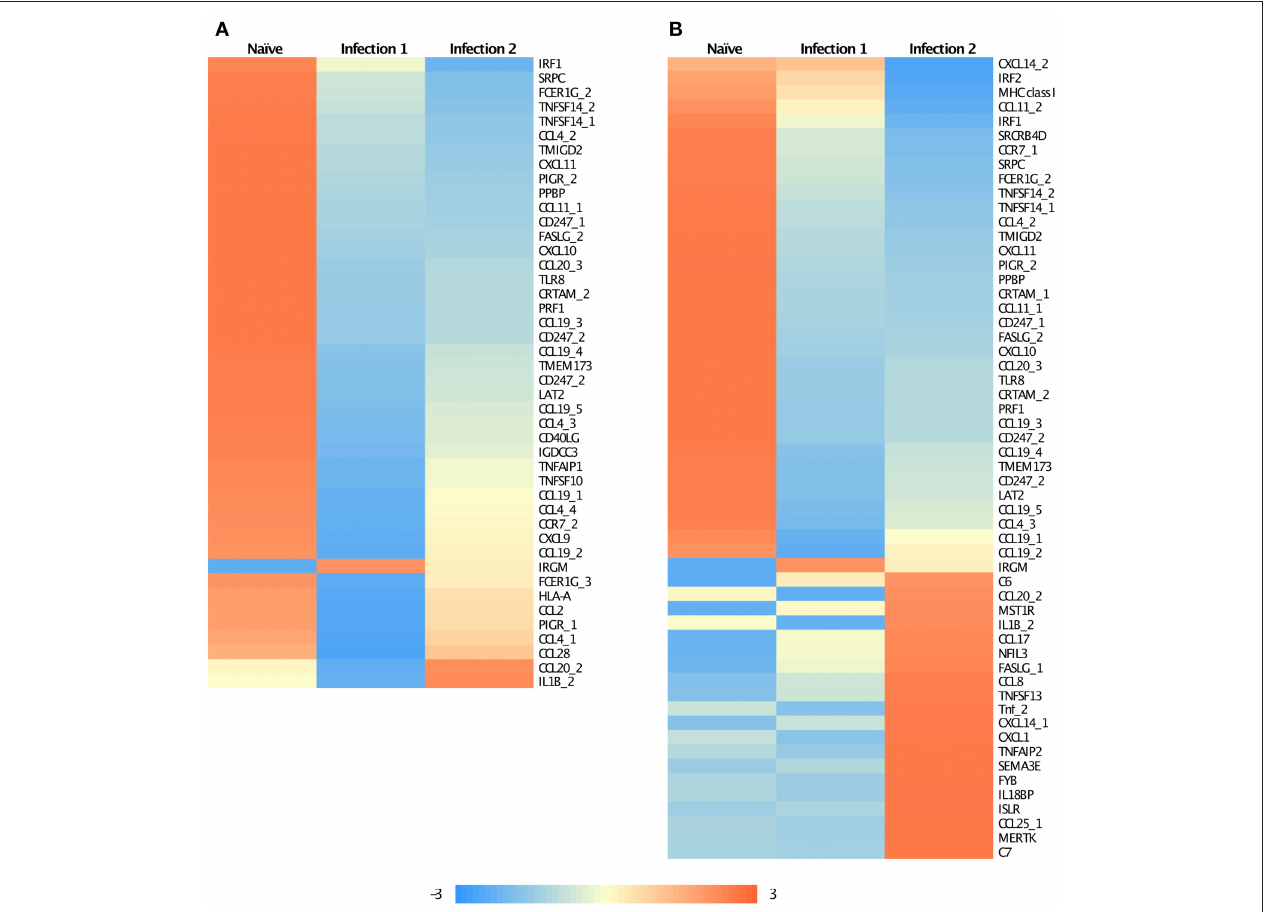
FIGURE 2 | Heatmap of the standardized FPKM gene expression, showing relative levels of abundance of differentially regulated immune related transcripts between (A) Naïve and animals during the first infection and (B) Naïve and animals during the second infection. Numbers following an underscore represent putative duplicated